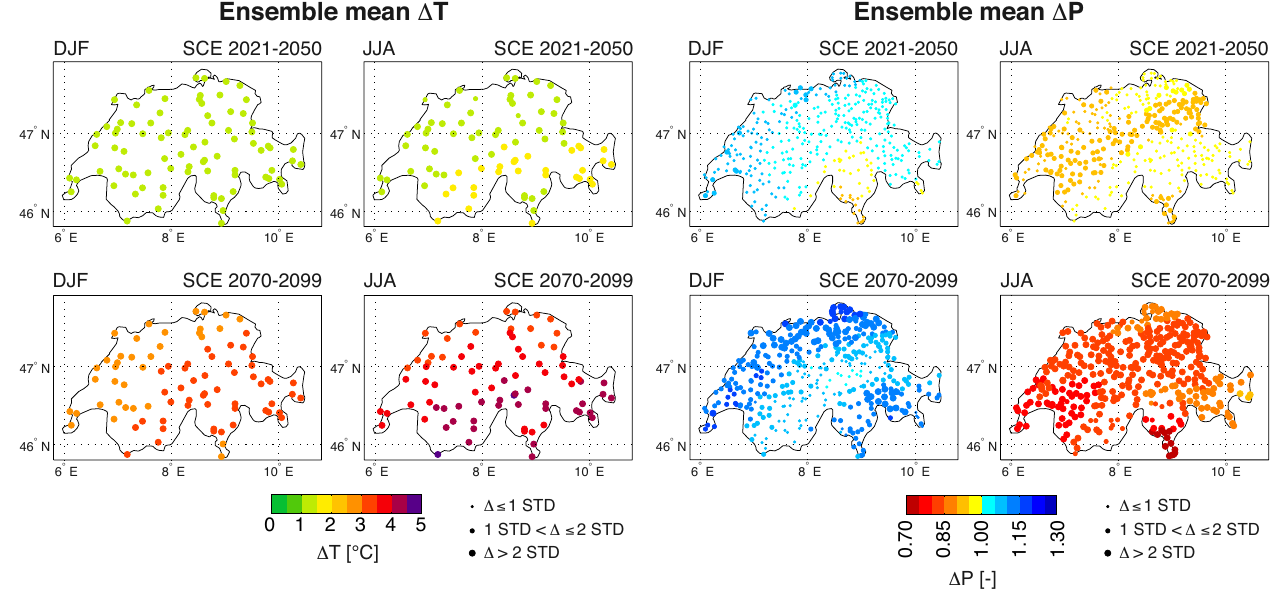
Fig. 9. Seasonal ensemble mean 1T (left panel group) and 1P (right panel group) at all station sites for both scenario periods 2021–2050 (top) and 2070–2099 (bottom) and the seasons DJF and JJA. The colour scale indicates the ensemble mean value of 1T or 1P . The size of the dot indicates the magnitude of 1T or 1P relative to the standard deviation (STD) of the estimated natural variability at the respective station. At stations having more than 10% missing values, no natural variability was estimated. These stations are not